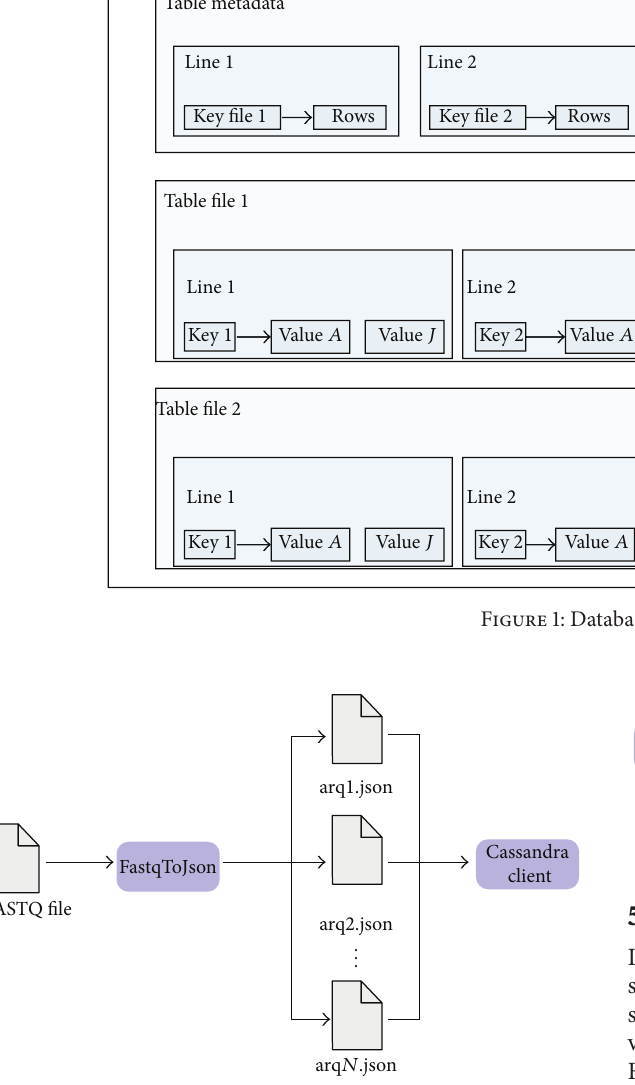
Figure 2: Stages of insertion.